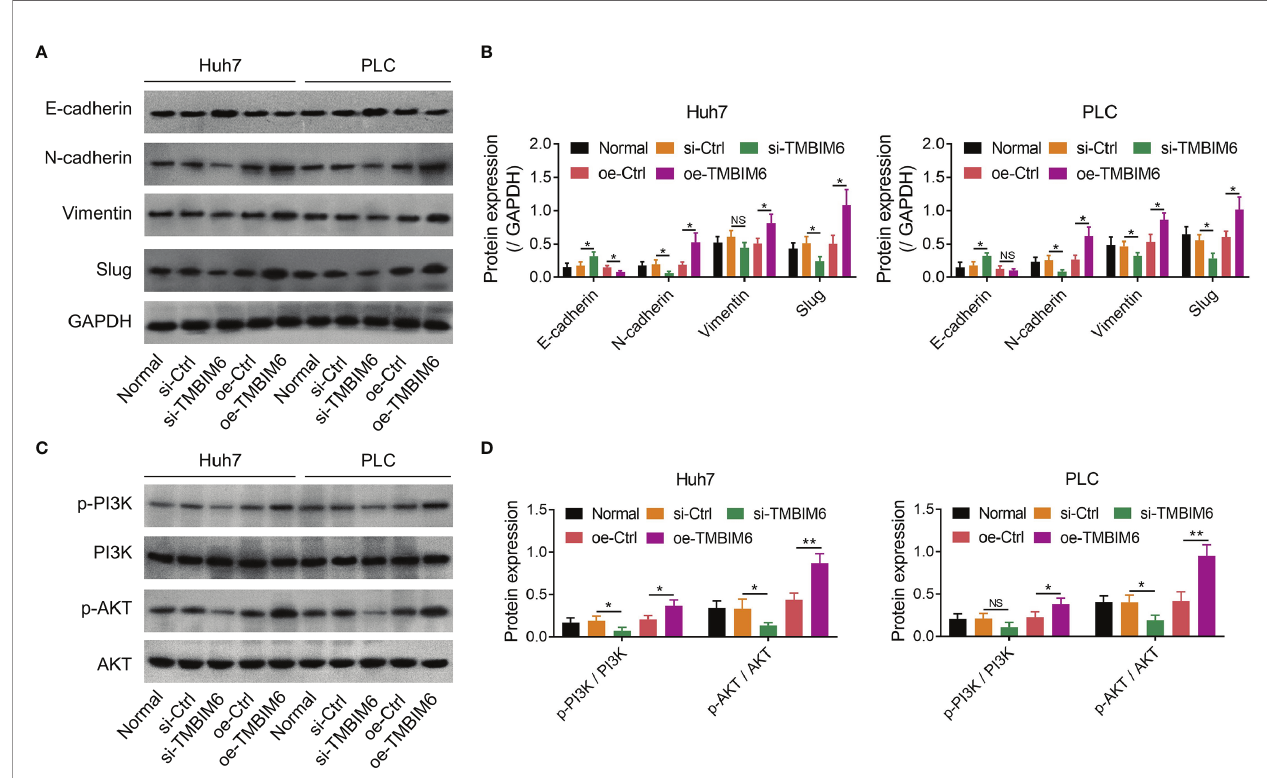
FIGURE 5 | Effect of TMBIM6 on EMT markers and PI3K/AKT pathway in HCC cells. Comparison of EMT markers (A, B) and phosphorylation of PI3K and AKT (C, D) among groups in Huh7 and PLC cells. HCC cells were cultured normally or transfected with control siRNA, TMBIM6 siRNA, control overexpression plasmids, or TMBIM6 overexpression plasmids. NS, not signi fi cant; * p < 0.05; ** p < 0.01. EMT, epithelial – mesenchymal transition; HCC, hepatocellular